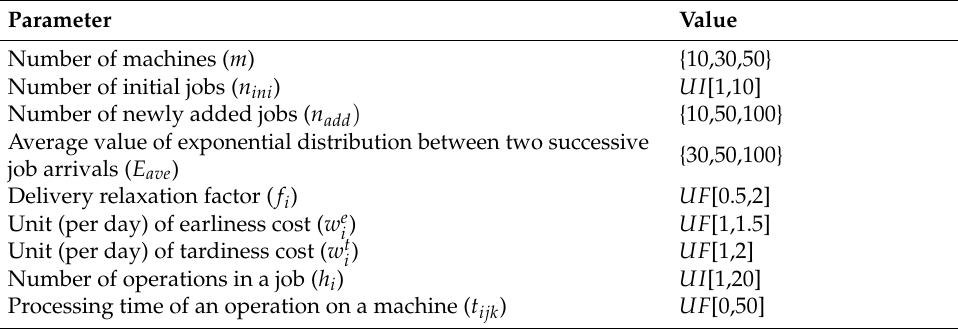
Table 3. Configuration of production example parameters.